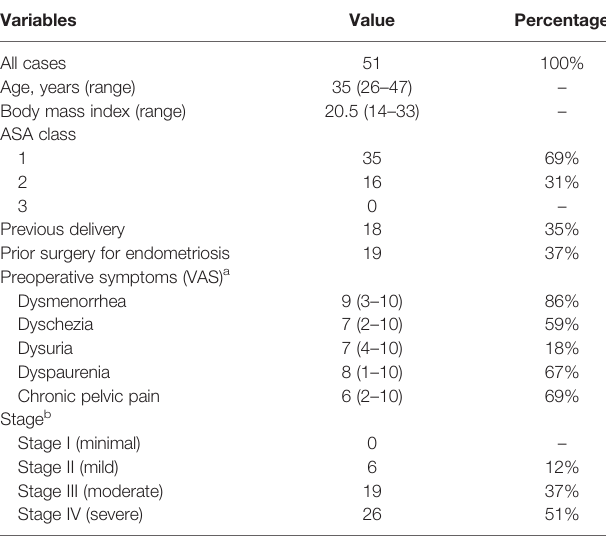
TABLE 1 | Characteristics of the patients.